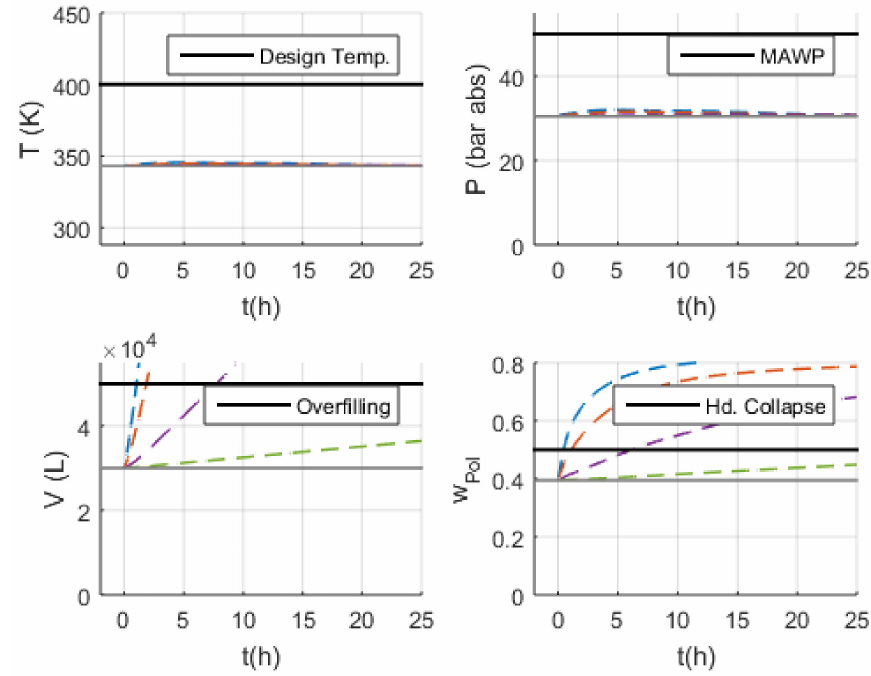
Figure 26. Behavior of critical variables in scenarios S-29 and S-30 with Model 1. Slurry mass flowrate: